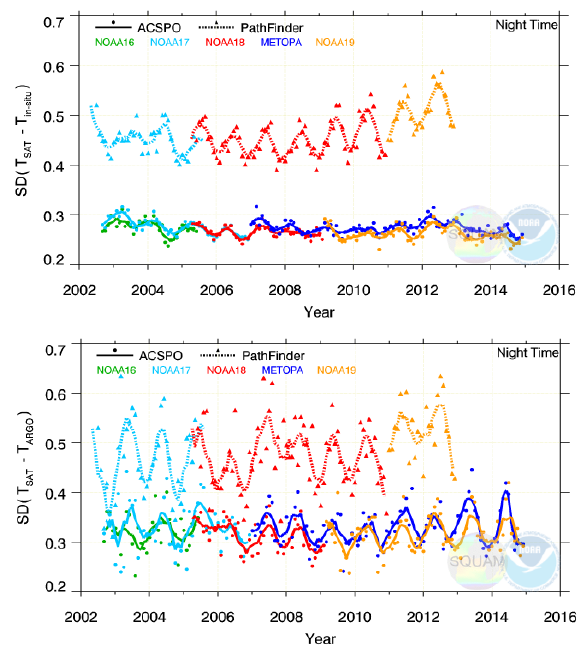
Figure 10. Same as in Figure 9 but for the SDs of Δ T S = T S − T in situ .